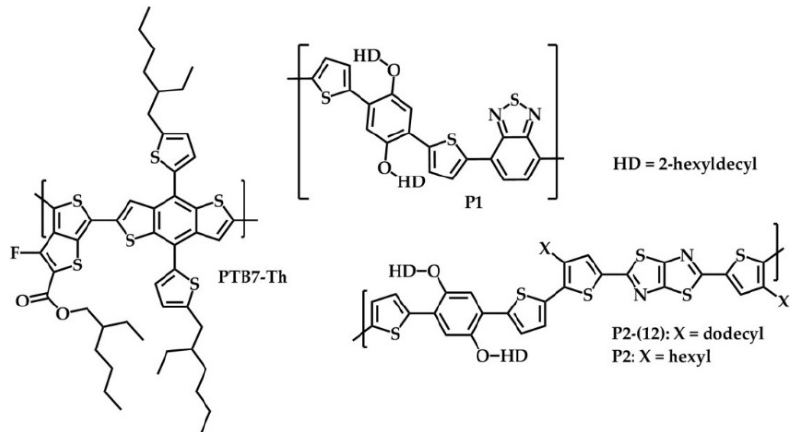
Figure 1. Chemical structures of a few low bandgap copolymer organic photovoltaics (OPV) reference materials [14–16]. PTB7 ‐ th, poly{4,8 ‐ bis [5 ‐ (2 ‐ ethylhexyl)thiophen ‐ 2 ‐ yl]benzo[1,2 ‐ b :4,5 ‐ b ′ ]dithiophene ‐